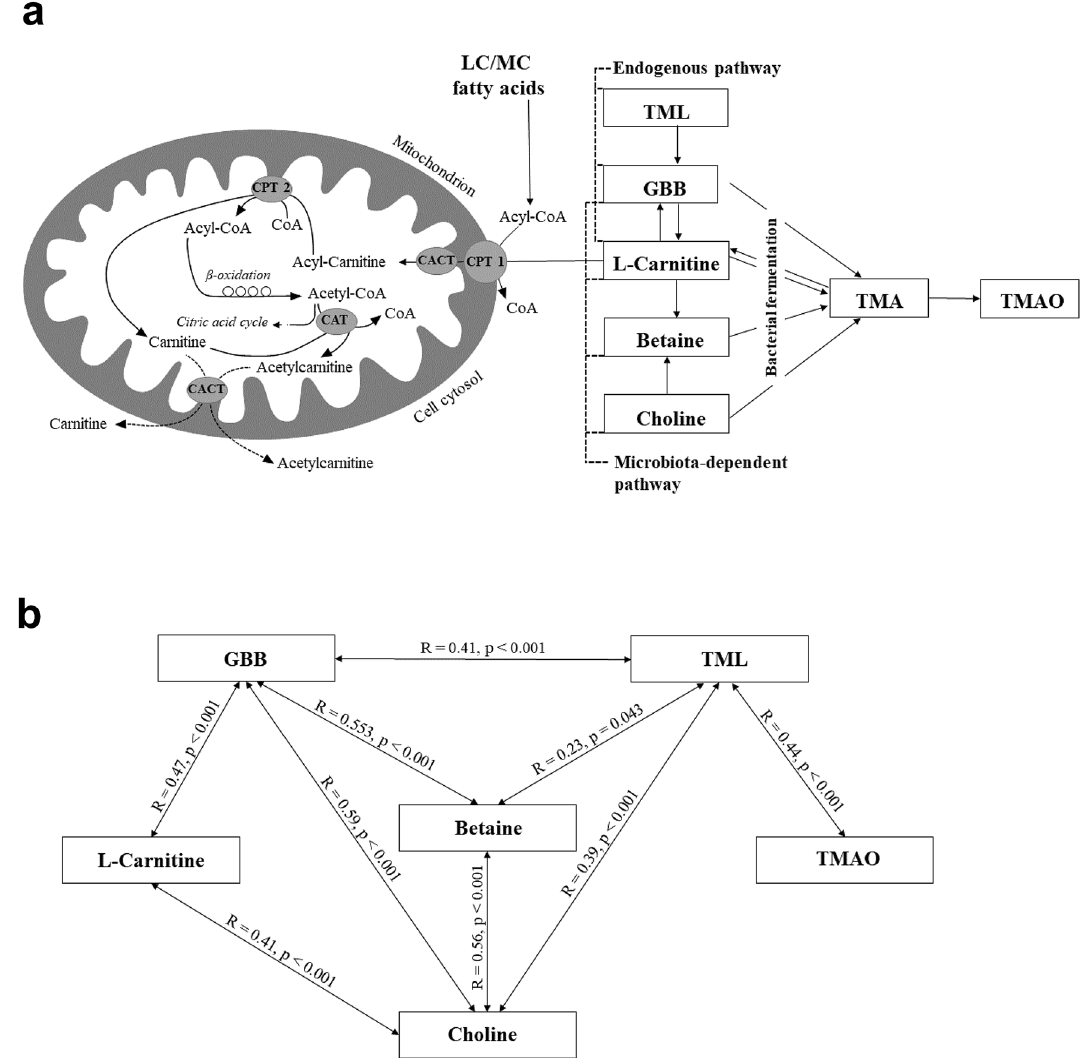
Figure 1. ( a ) Overview of fatty acid oxidation, carnitine biosynthesis and metabolism, and TMAO formation. ( b) Relationship between serum carnitine- and choline derivatives in RA patients with different periodontal conditions (N = 78). CPT, carnitine palmitoyl-transferase; CACT, carnitine-acylcarnitine translocase; TML, trimethyl lysine; GBB. γ-butyrobetaine; TMA, trimethylamine; TMAO, trimethylamine